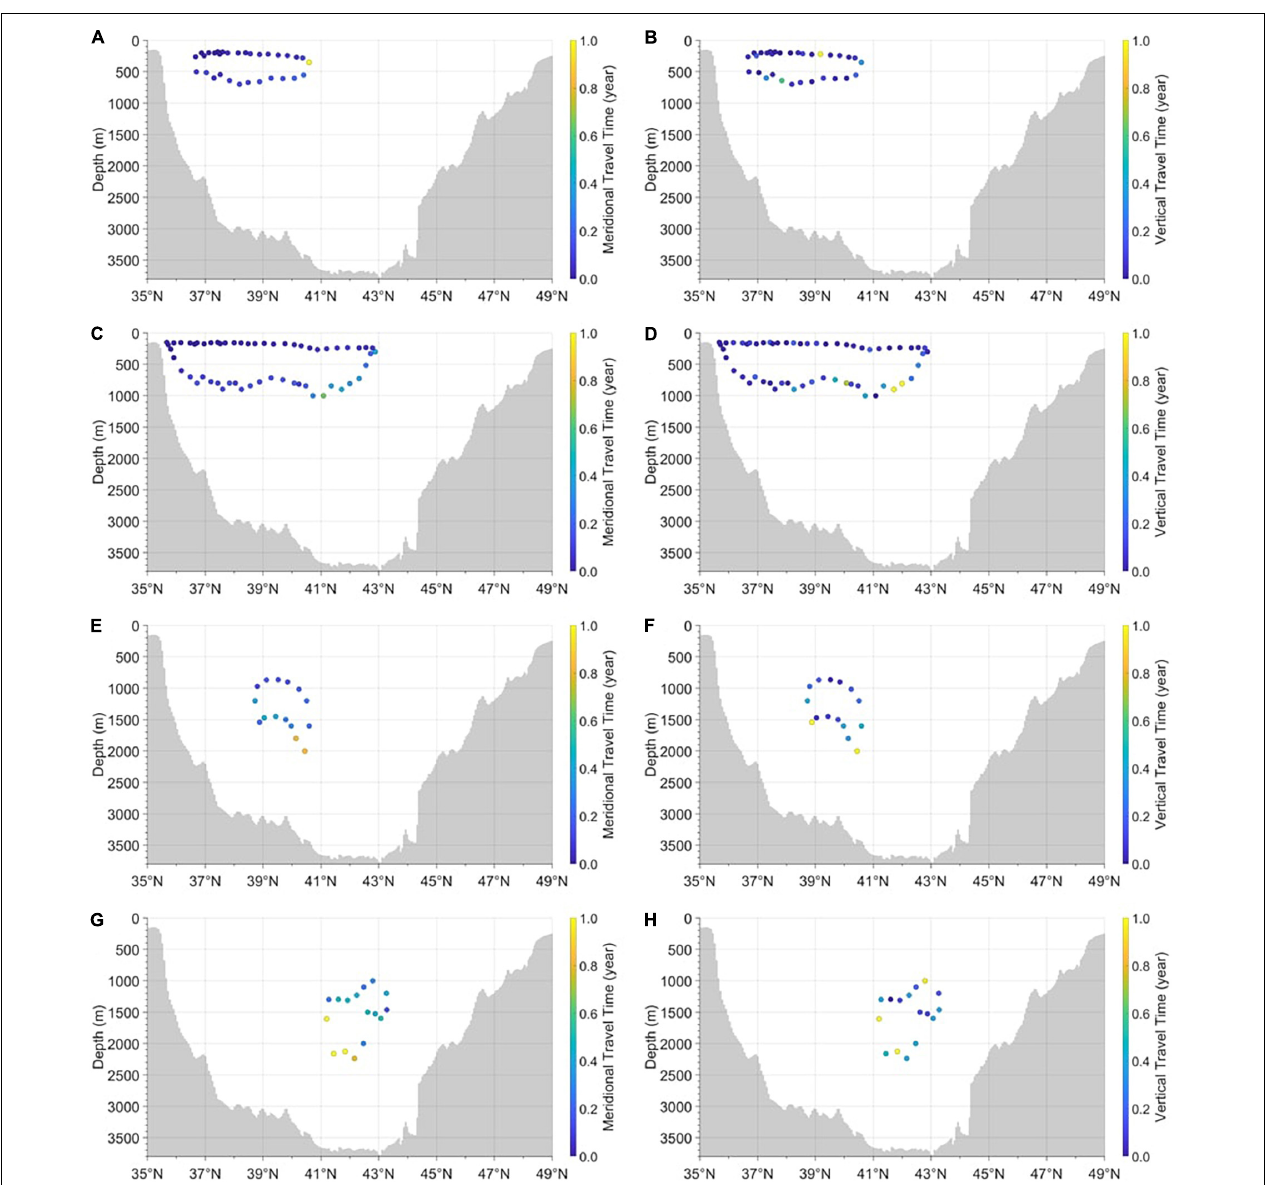
FIGURE 6 | Meridional and vertical travel times of 0.3 Sv (A,B) , 0.1 Sv (C,D) , and − 0.1 Sv (E–H) streamlines for the mean convection case in the meridional overturning stream function. Turnover times of the 0.3 Sv (A,B) , 0.1 Sv (C,D) , − 0.1 Sv (E,F) , and − 0.1 Sv (G,H) streamlines are 17.91 years (= 3.62 + 14.29), 18.04 years (= 6.52 + 11.52), 23.60 years (= 4.83 + 18.77), and 16.95 years (= 9.81 + 7.14),